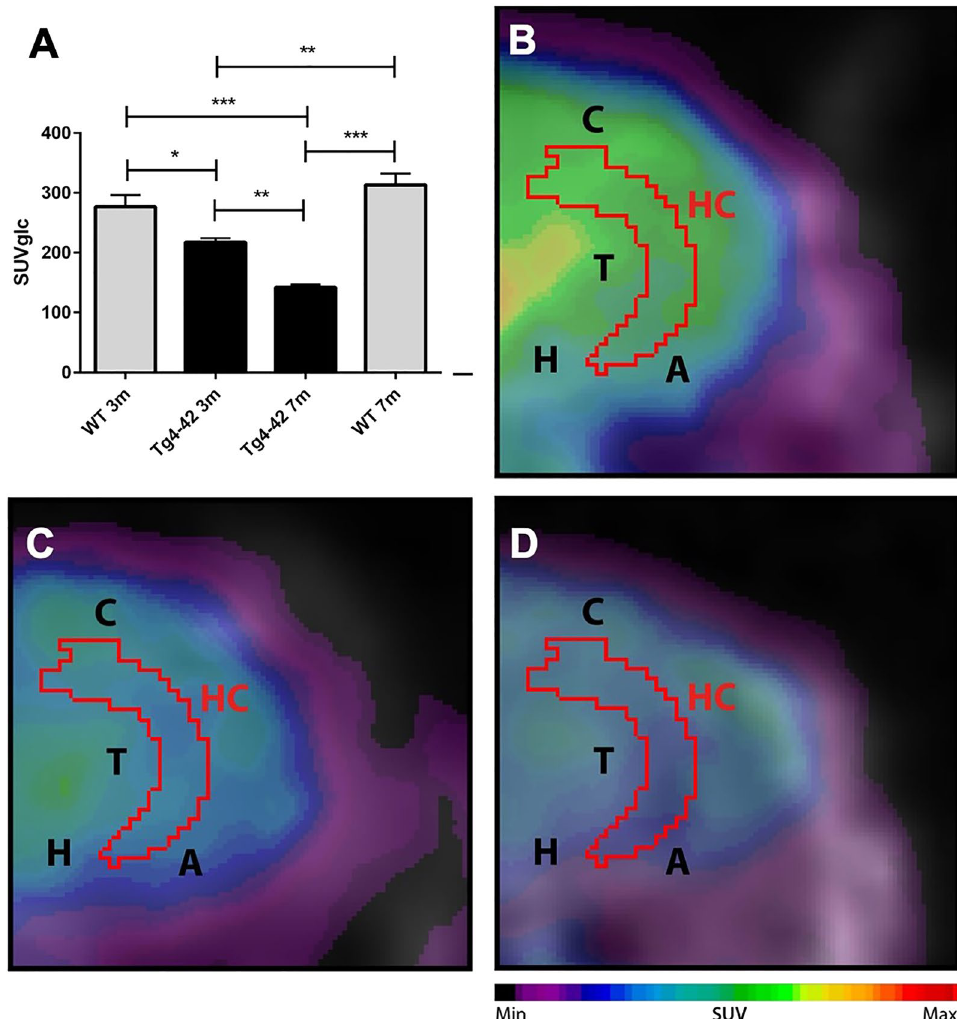
Figure 7. 18 F-FDG-PET shows decreased metabolic activity in the hippocampus of Tg4-42 mice. ( A ) Quantification of 18 F-FDG uptake in the hippocampus. 18 F-FDG-uptake in the hippocampus was significantly reduced in 3m and 7m Tg4-42 mice compared to same-aged WT animals. Hypometabolism in Tg4-42 increases age-dependently. ( B ) Fused 18 F-FDG-PET/MRI of a WT mouse in coronal view. ( C ) Fused 18 F-FDG-PET/MRI of a 3-month-old Tg4-42 mouse in coronal view with distinctly lower FDG uptake compared to the WT mouse. ( D ) Fused 18 F-FDG-PET/MRI of a 7-month-old Tg4-42 mouse in coronal view with distinctly lower FDG uptake compared to WT and 3-month-old Tg4-42 mice. One-way-ANOVA; *** p < 0.001; ** p < 0.01; * p < 0.05; WT wild-type; m months. A Amygdala, C Cortex, H Hypothalamus, Hc Hippocampus, T